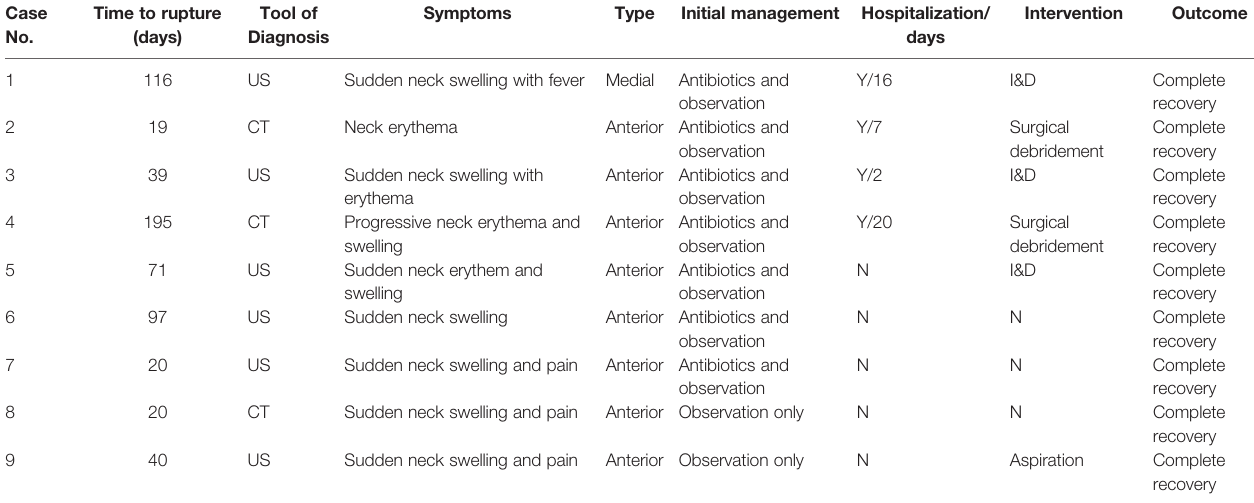
TABLE 2 | Clinical and imaging manifestations of the 9 patients with thyroid nodule rupture after RFA. Case